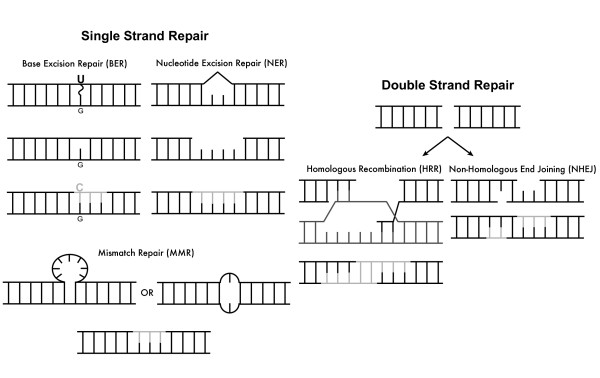
A comparison of the five major DNA repair pathways. (See text for explanation.) Newly synthesized DNA is indicated in grey.